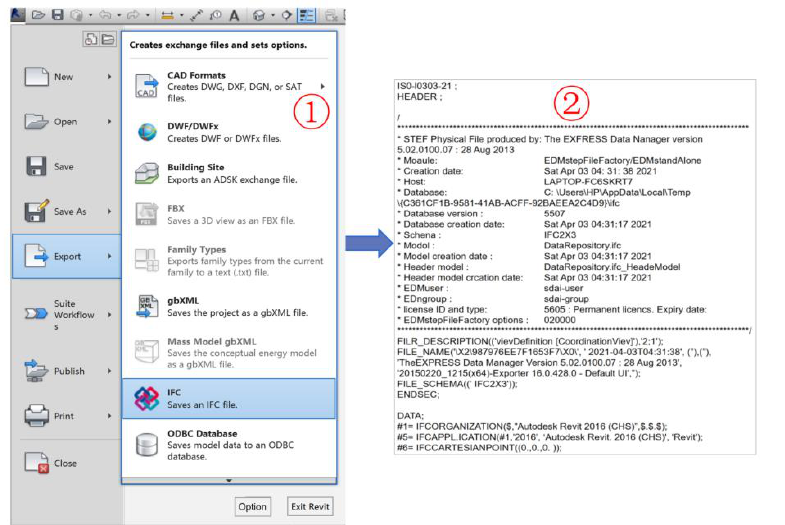
12 of 21 Figure 11. BIM model in the construction stage.